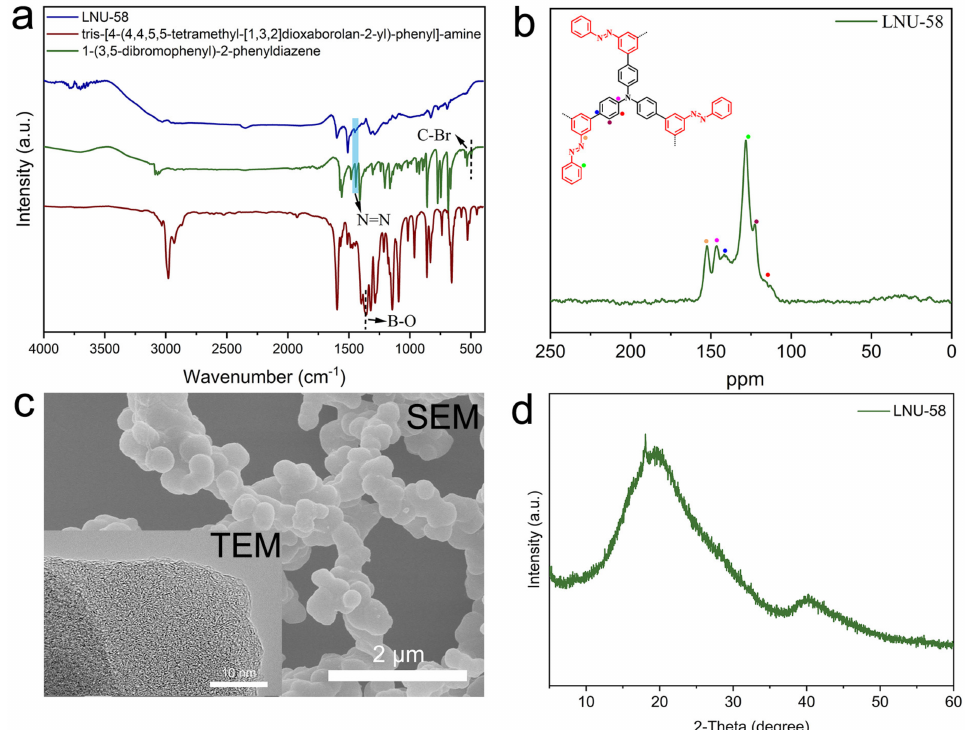
Figure 2. ( a ) FT-IR spectra of LNU-58 and related raw materials; ( b ) solid-state 13 C NMR spectrum of LNU-58; ( c ) SEM image and TEM image (insert) of LNU-58; ( d ) PXRD pattern of LNU-58.